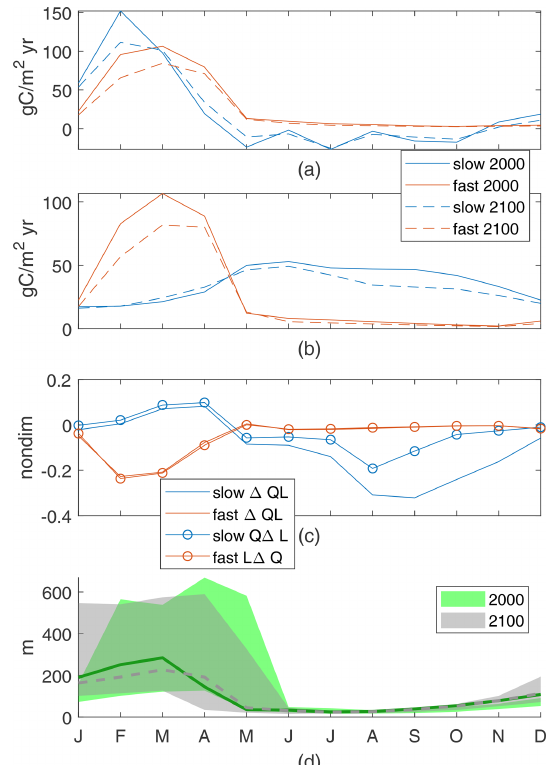
Figure 11. Porcupine Abyssal Plain nutrient supply (a) and pro- duction of particles (b) . Production controls (c) , normalized by maxQL(2000) values for the 2000s: 0.022 for the slow case and 0.015 for the fast case. The discrepancy for the slow case is mainly due to L(cid:49)Q . Range and mean of monthly-maximum MLD (d)